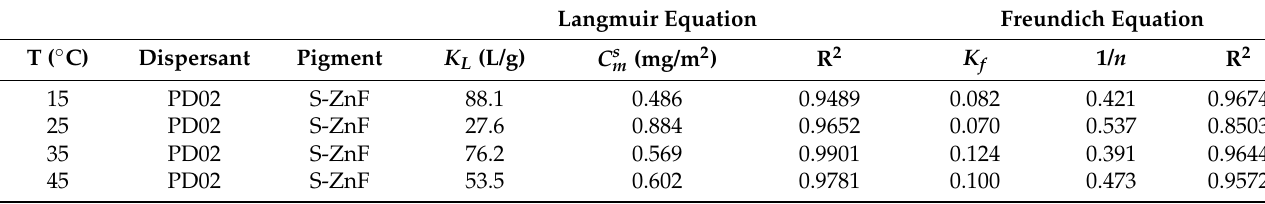
Table 4. Parameters simulated by the Langmuir equation and Freundich